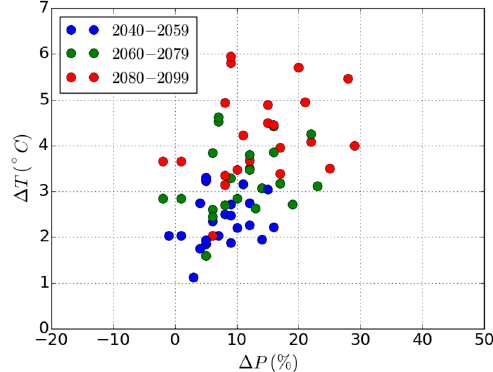
Figure 2. Scatterplot of average changes in precipitation and temperature for 23 GCM projections between control period (1961–1982) and three future time periods (i.e., 2040–2059, 2060–2079, and 2080–2099).